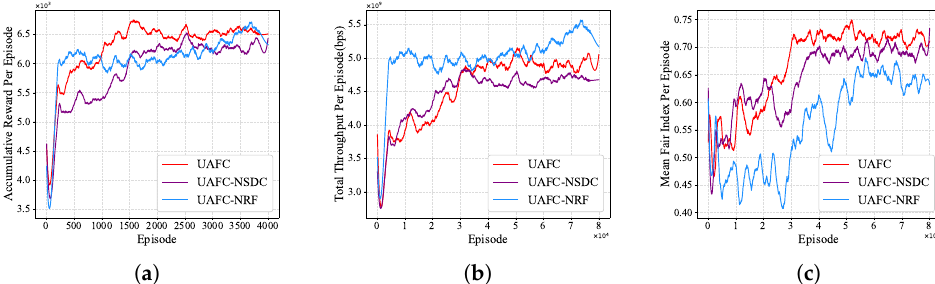
Figure 6. The training process of the UAFC, UAFC-NSDC, and UAFC-NRF algorithm. ( a ) Accumula- tive reward per episode. ( b ) Total fair throughput per episode. ( c ) Mean fair index per